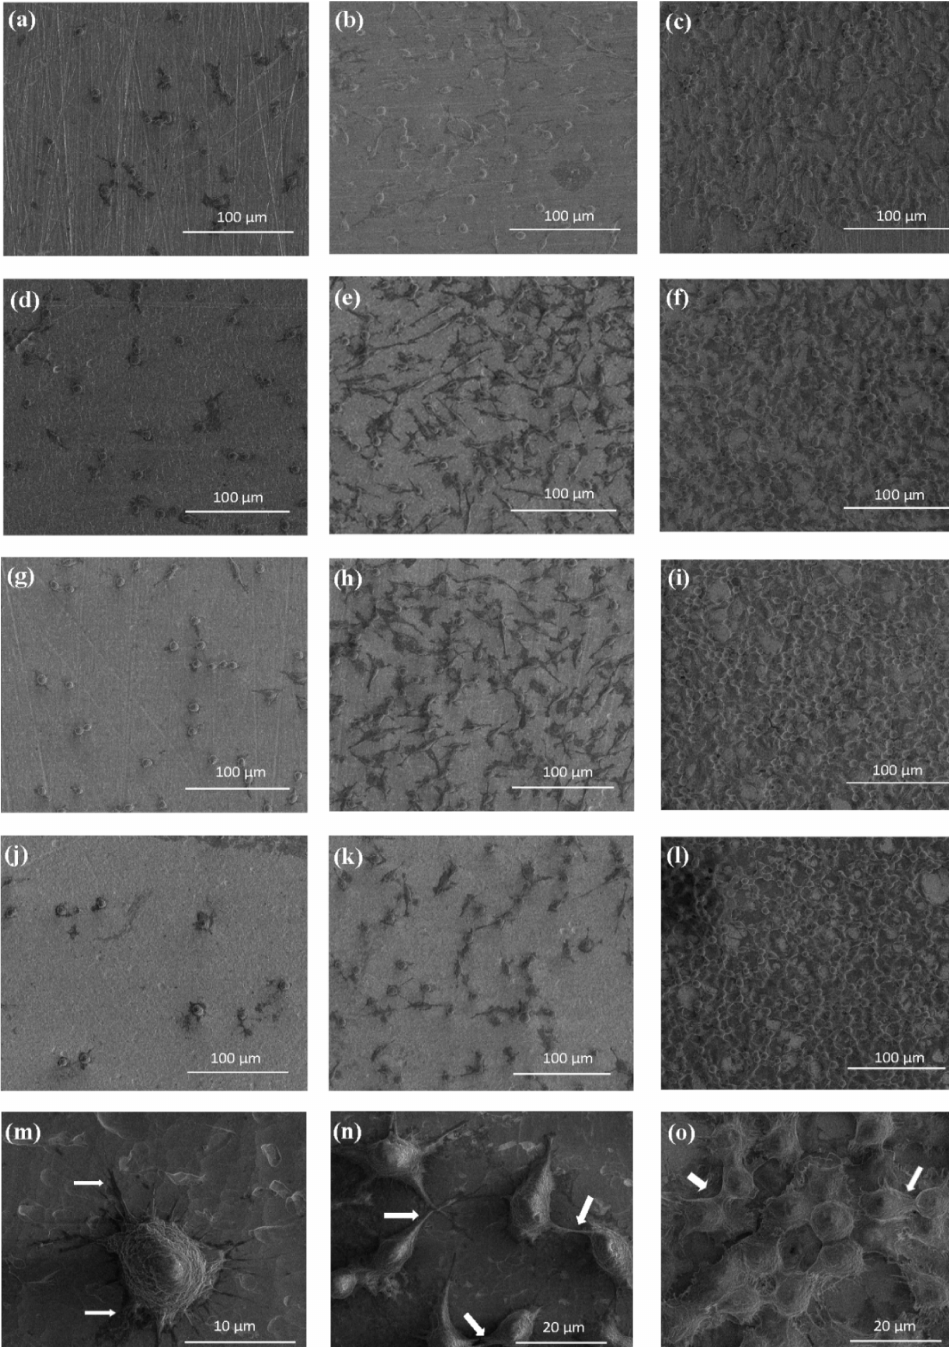
Figure 5. SEM images showing the cell adhesion (24 h) and proliferation (72 h and 5 days) of L929 murine fibroblasts on the Ti6Al4V alloy and TNT5, TNT10, and TNT15, after 24 h ( a , d , g , j ), 72 h ( b , e , h , k ), and 5 days ( c , f , i , l ) of incubation time, respectively. The arrows indicate the filopodia spread between fibroblasts incubated with TNT5 for 24 h, 72 h, and 5 days ( m – o , respectively).